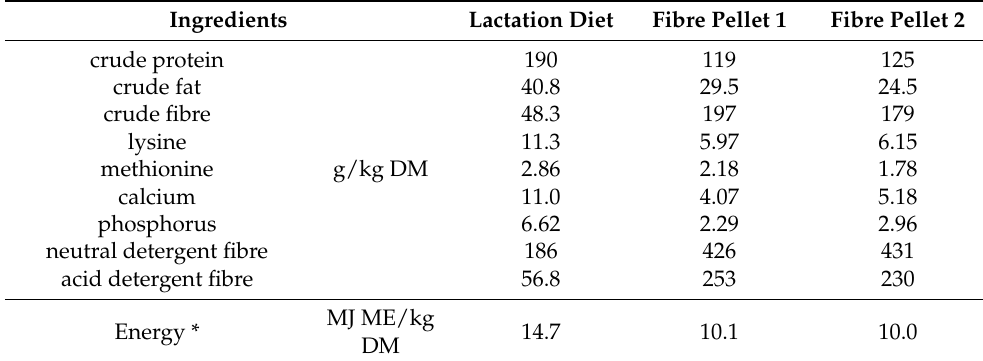
Table 3. Chemical composition of the lactation diet fibre pellet 1 and fibre pellet 2.